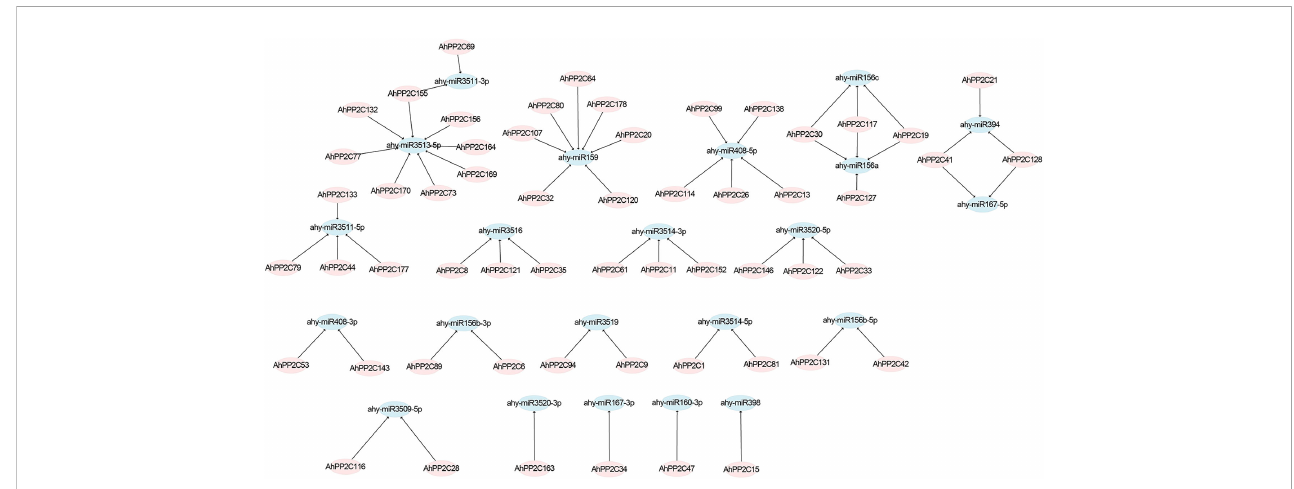
FIGURE 4 Prediction of putative miRNAs targeting AhPP2C s. The pink shapes correspond to AhPP2C s, and blue shapes indicate predicted miRNAs.